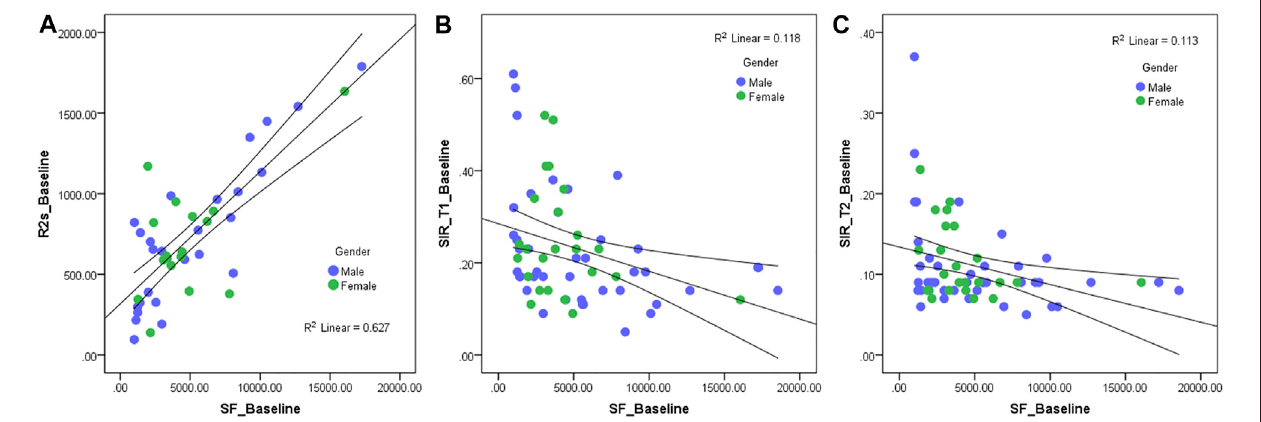
FIGURE 4 | Scatter diagram of serum ferritin and R2* (A) , hepatic muscle signal ratio (SIR)_T1 (B) , and SIR_T2 (C) at baseline. The R2* value has a signi fi cantly positive correlation with serum ferritin (r = 0.649, p < 0.05), and the SIR_T1 and SIR_T2 have a signi fi cantly negative correlation with the serum ferritin (r = − 0.387 and -0.336, p <